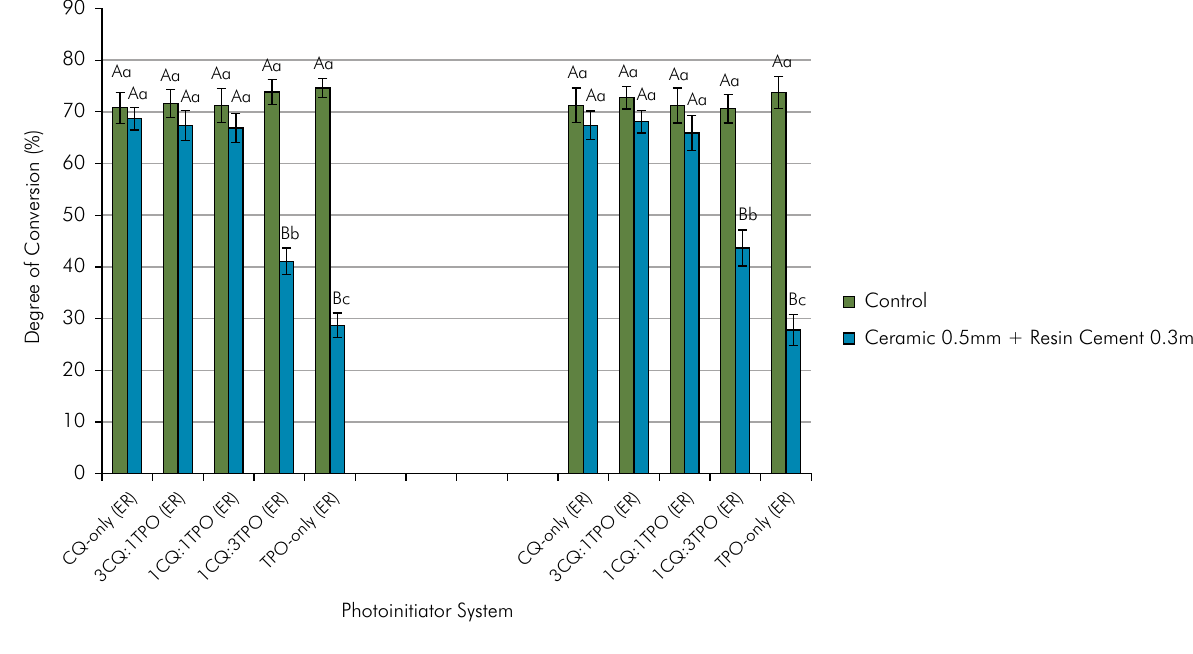
Figure 3. Degree of conversion of the tested experimental adhesives with different photoinitiator systems photoactivated through the ceramic veneer and resin cement layers